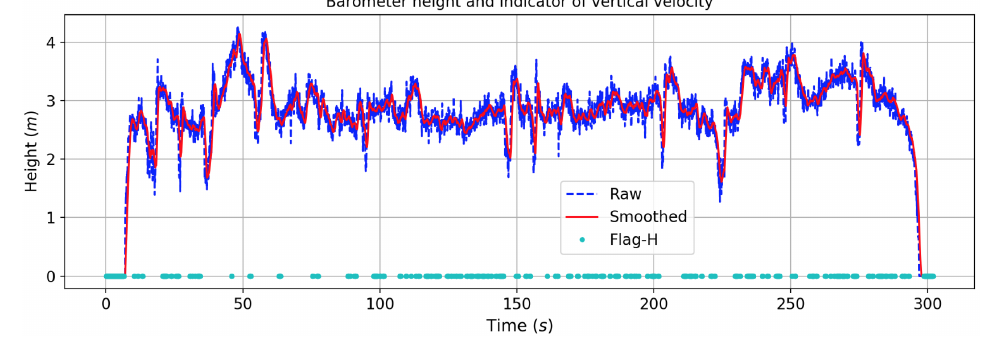
Figure 5. Barometer data and height-change detection